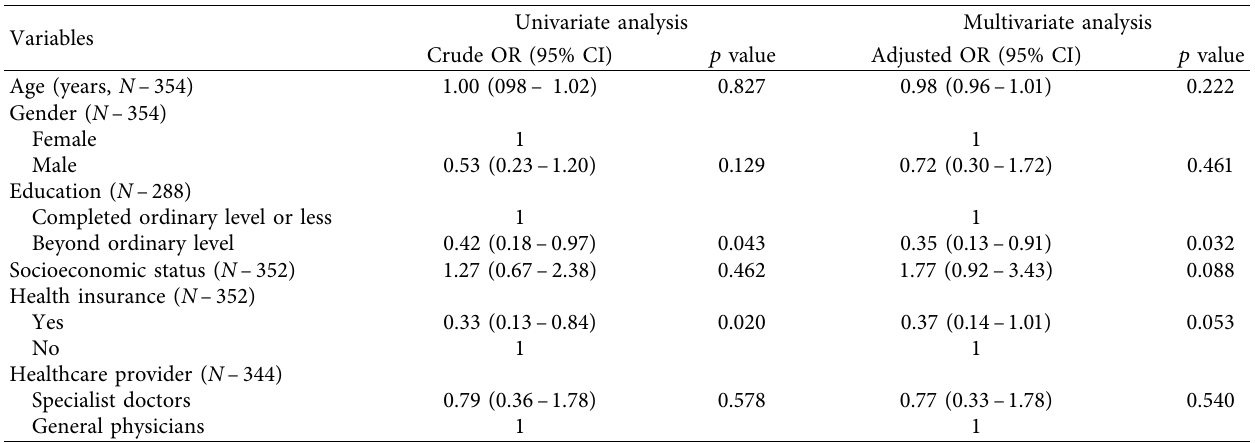
Table 5: Regression analysis of the appropriateness of CT